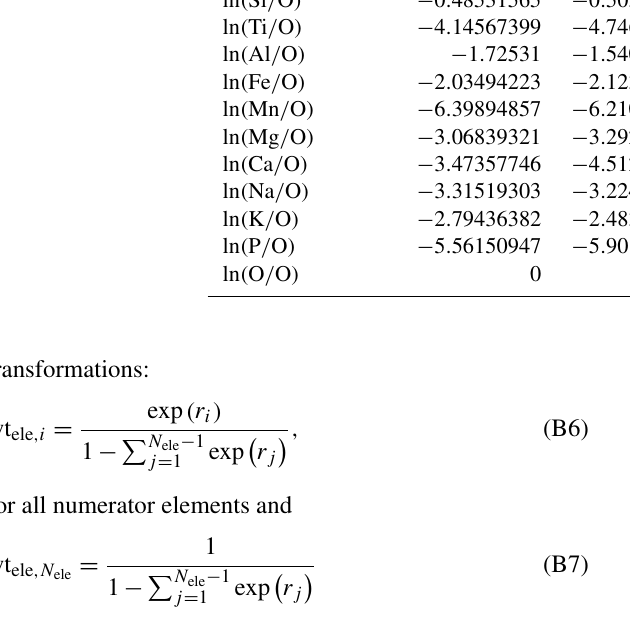
Table B3. Log ratio of element weight percentages, with respect to oxygen wt%. Sample JT01 JT02 JT19 JT20 Element log